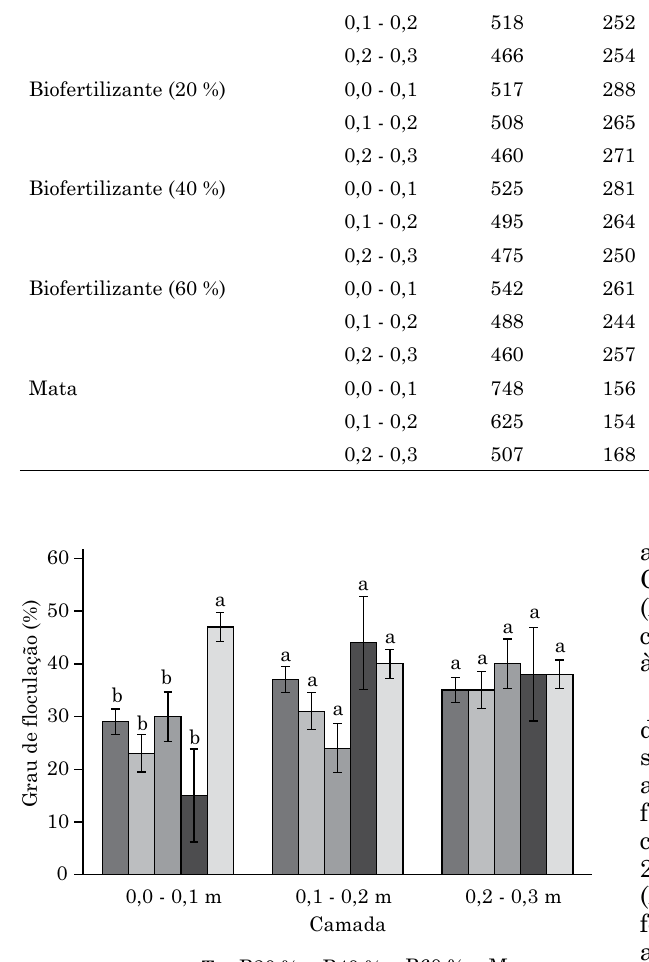
Figura 1. Grau de floculação, com os erros da média, para as áreas sob cultivo de figo e mata secundária (T - Testemunha; B20 % - Biofertilizante 20 %; B40 % - Biofertilizante 40 %; B60 % - Biofertilizante 60 %; e M - Mata nativa). Médias seguidas pela mesma letra na camada não diferem pelo teste de Dunnett